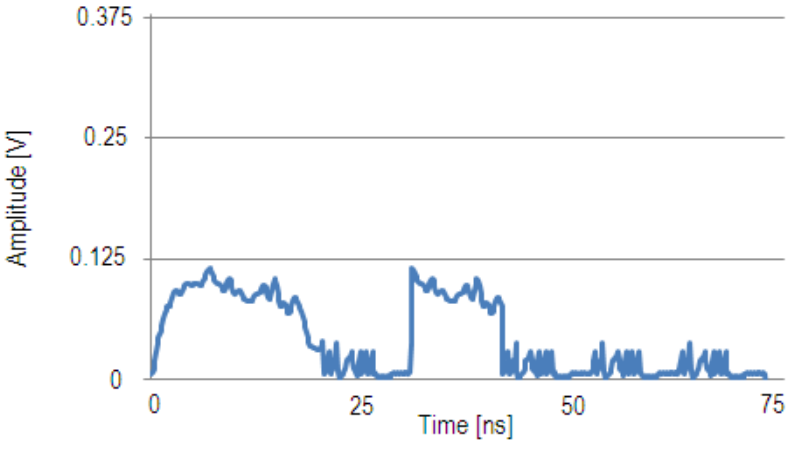
Figure 5 . Correlation output with a mismatched input signal 1000.